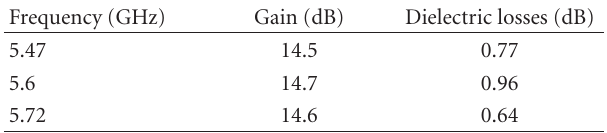
Table 2: Simulated gain and dielectric losses.